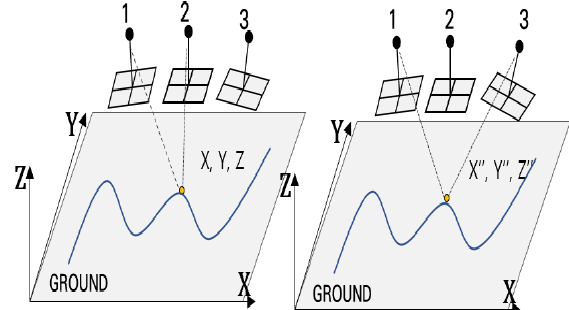
Figure 4. Stereo models with common point